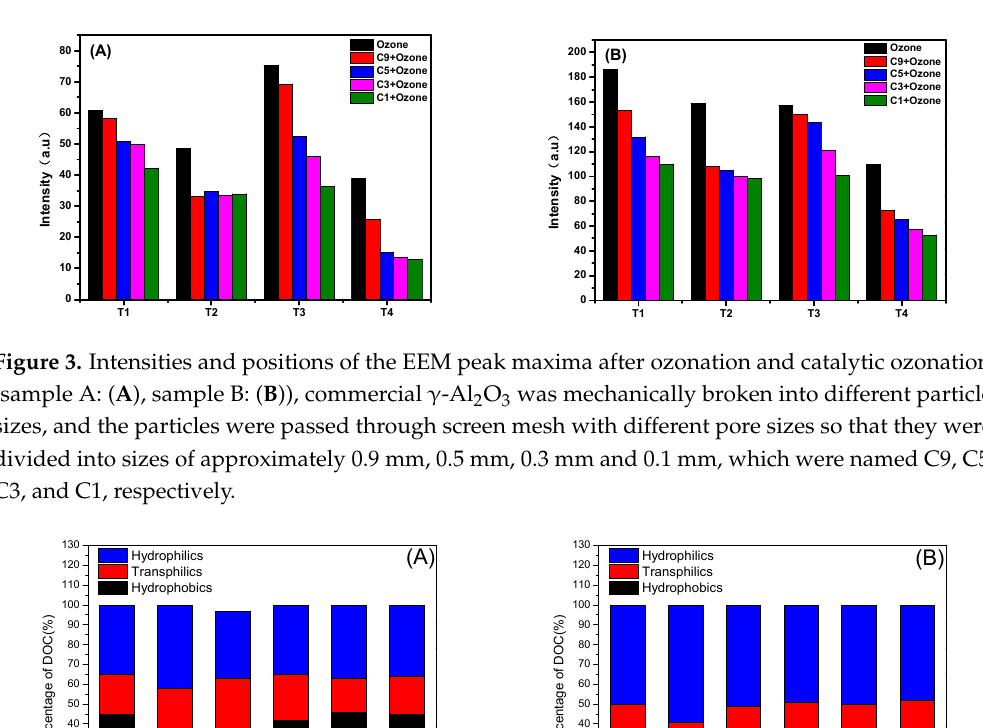
(B) Figure 3. Intensities and positions of the EEM peak maxima after ozonation and catalytic ozonation. (sample A: ( A ), sample B: ( B )), commercial γ -Al 2 O 3 was mechanically broken into different particle sizes , and the particles were passed through screen mesh with different pore sizes so that they were divided into sizes of approximately 0.9 mm, 0.5 mm, 0.3 mm and 0.1 mm, which were named C9, C5, C3, and C1, respectively. 2.2. Effect of Hydrophobics/Hydrophilics by O 3 and γ -Al 2 O 3 DOM in biotreated ef fl uent with treatment by O 3 and different sizes of γ -Al 2 O 3 /O 3 were